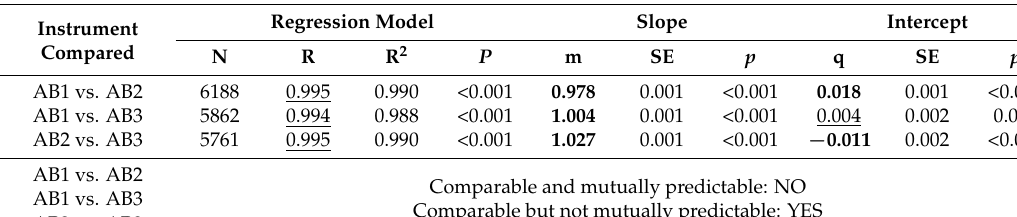
Table 4. Regression parameters between AB (data averaged on a 1-min basis). N: number of data; R: Pearson correlation coefficient; p : significance; m: slope; q: intercept; SE: standard error. Regression parameters that did not meet the Watson et al. criteria are marked in bold while values that met these criteria are